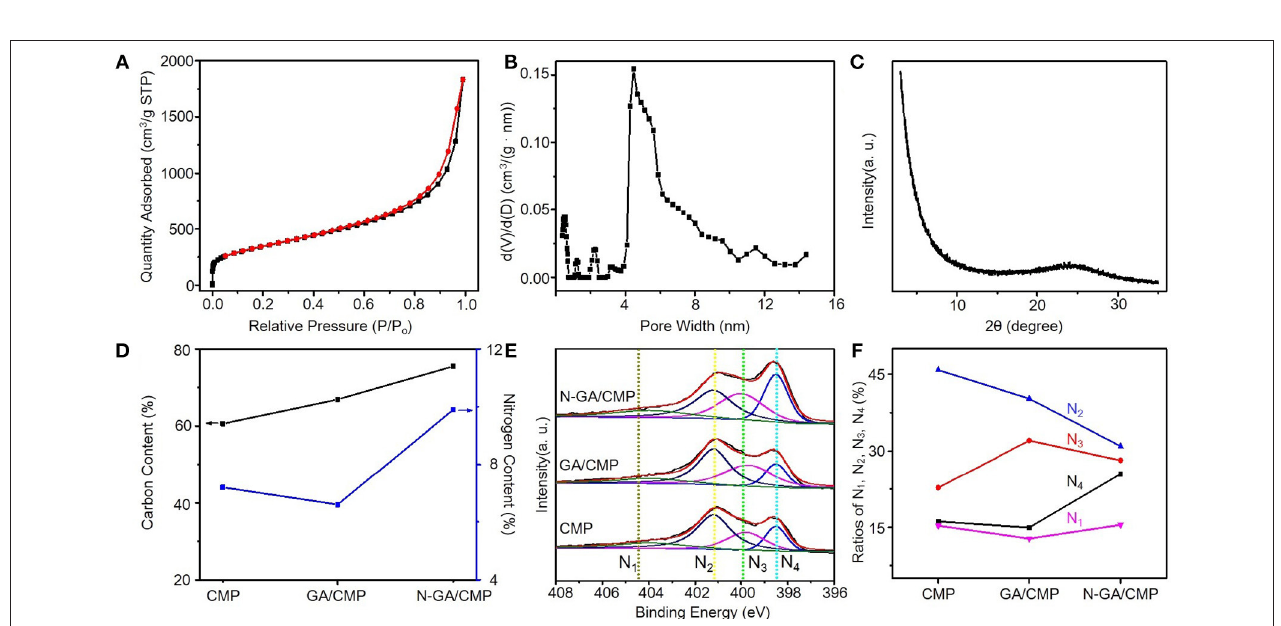
FIGURE 2 | (A) Nitrogen adsorption and desorption isotherms of CMPs (red) and N-GA/CMPs (blue). (B) Pore size distribution of CMPs and N-GA/CMPs. (C) XRD pattern of N-GA/CMPs. (D) EA of N-GA/CMPs for carbon (black) and nitrogen (blue). (E) XPS N 1s spectra of CMPs, GA/CMPs and N-GA/CMPs (N 1 , oxide nitrogen; N 2 , quaternary nitrogen; N 3 , pyrrolic nitrogen; N 4 , pyridinic nitrogen). (F) Ratios of different configurations of nitrogen in the materials.